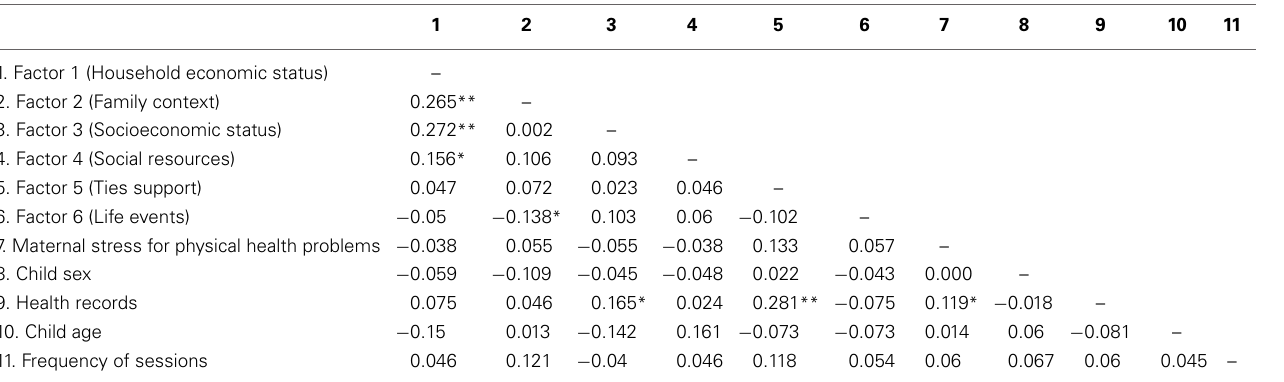
Table 6 | Correlations for independent variables in the SIP.